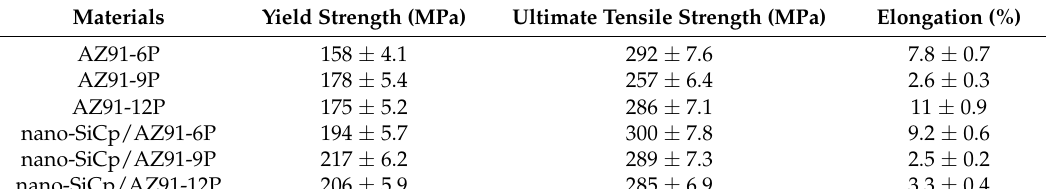
Table 1. The mechanical properties of AZ91 alloy and nano-SiCp/AZ91 composites.